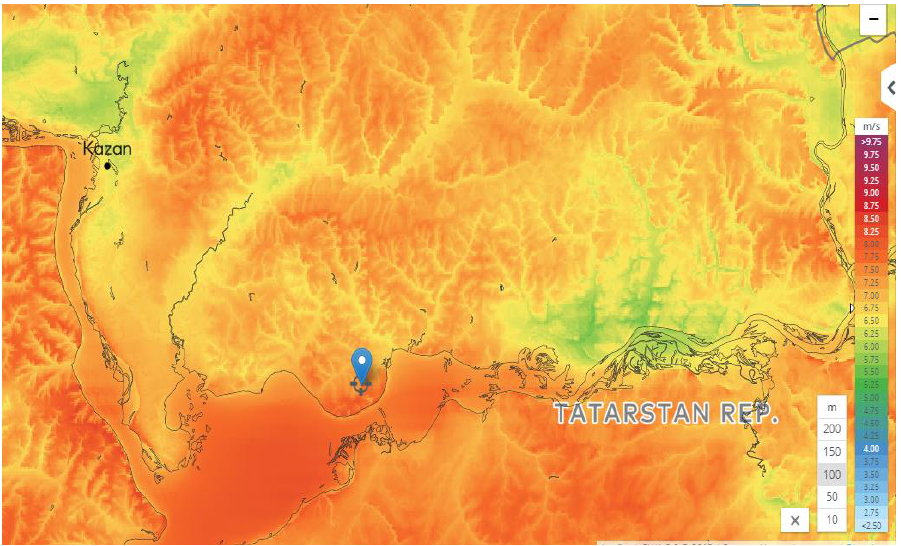
Figure 2. Map presenting the mean wind speed around